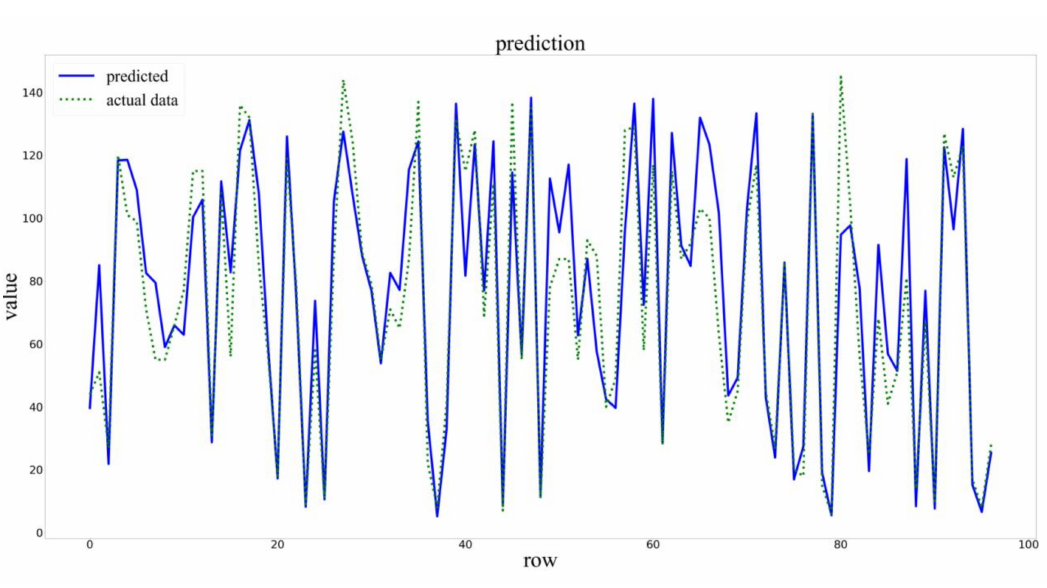
Figure 6. Prediction results of the PCA–BLSTM